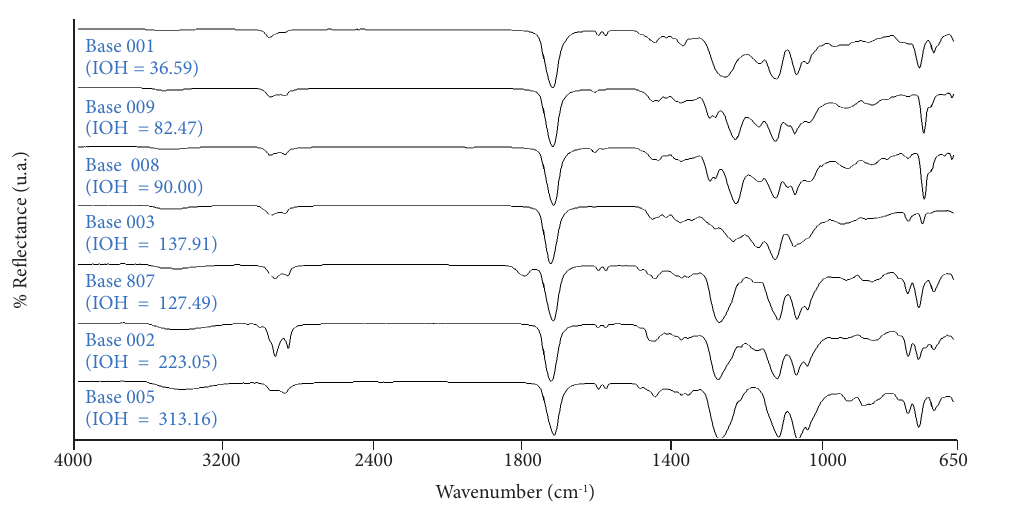
Figure 9. FT-MIR (UATR) spectra of polyester samples (IOH in mg KOH/g) analyzed as received. Figure 10. FT-MIR/UATR calibration curve for polyesters – A 3500 versus IOH (measured by wet chemistry method, supplier’s data). FT-MIR = Fourier transform medium infrared; IOH =